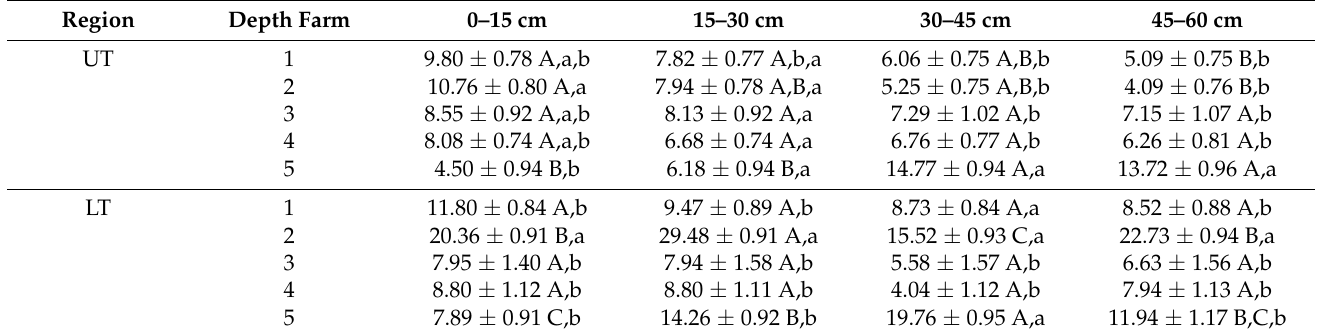
Table 8. Influence of farm x depth interactions on C/N ratio (mean ± standard error) under mixed pastures in the Upper (UT) and Lower (LT) Tsitsikamma dairy